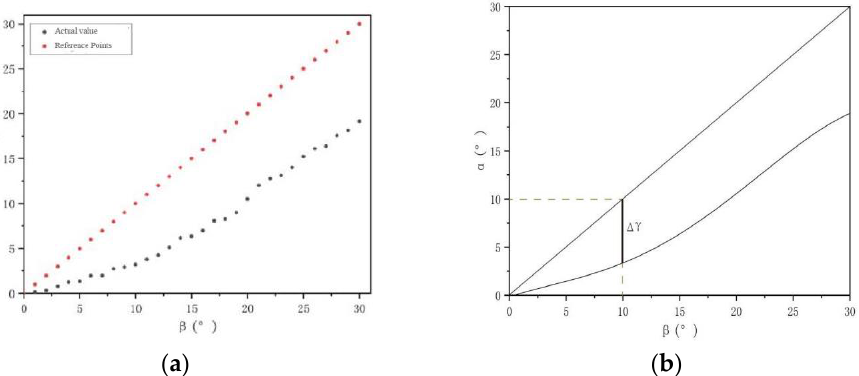
Figure 18. Fitting diagram of brush wire rebound: ( a ) Measured angle of brush wire rebound, ( b ) Fitted angle of rebound.